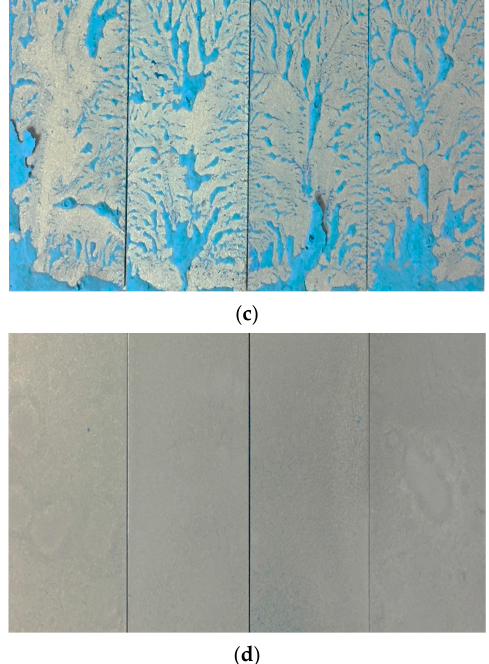
Figure 6. Fouled area of ( a ) PU coating (R-0: 30.42%), ( b ) PU coating blended with silica nanoparticle (N/7.0: 3.37%), ( c ) silane-modified PU coating blended silica nanoparticle (S/7.0: 98.80%) ( d ) and dual-layer coating with PU and silica nanoparticles in paint thinner (T/20/1.0: 0.06%).